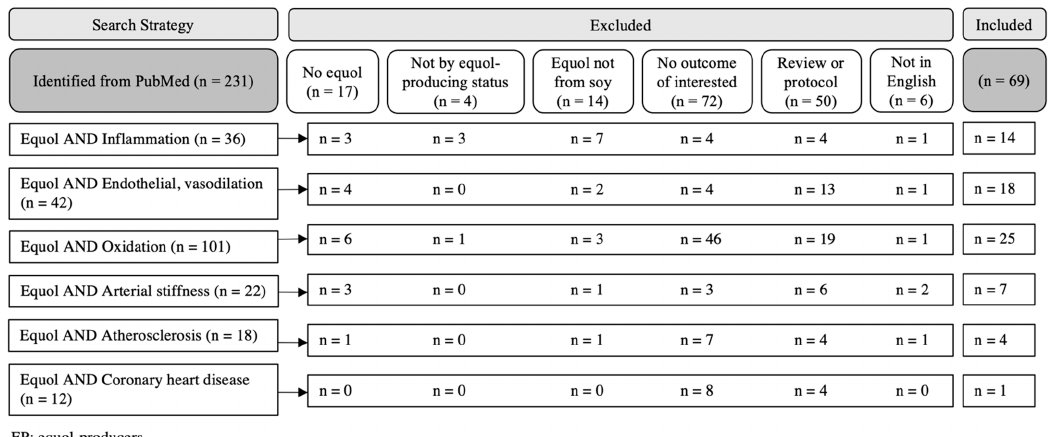
Figure 1. Search strategies in PubMed (inception to 28 July 2021) and the literature selection process.